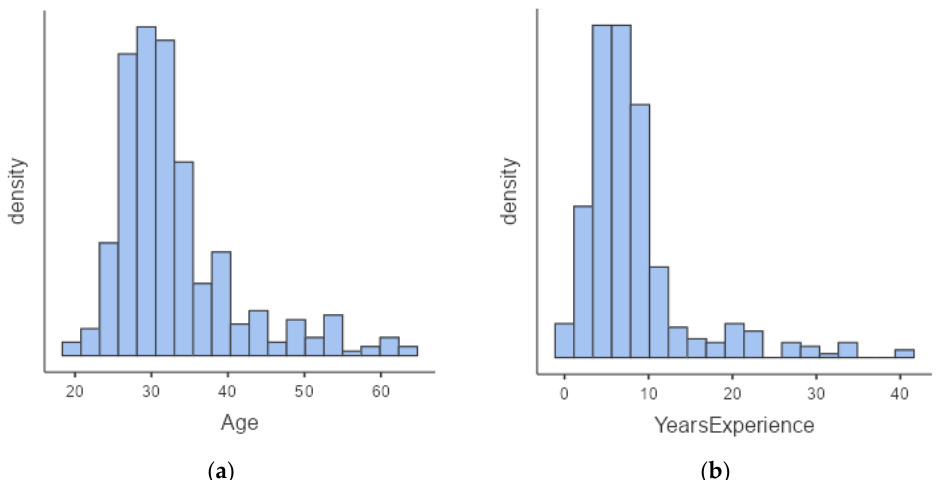
Figure 1. Panel ( a ) is a histogram of the age of the sample; Panel ( b ) is a histogram of the sample’s years of experience. N = 376.